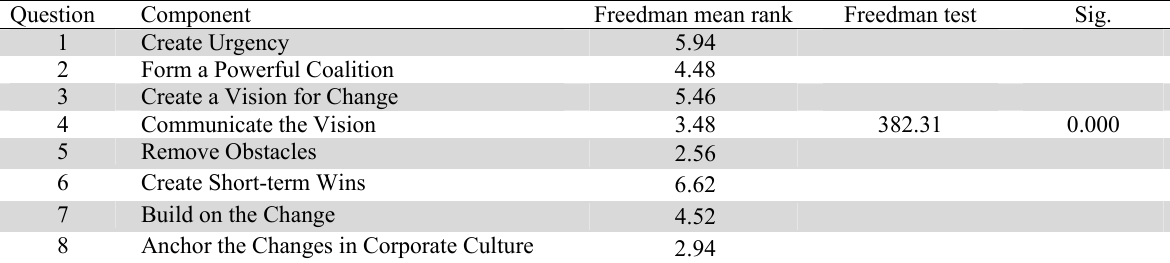
The results of ranking the effects of eight Kotter’s components (df